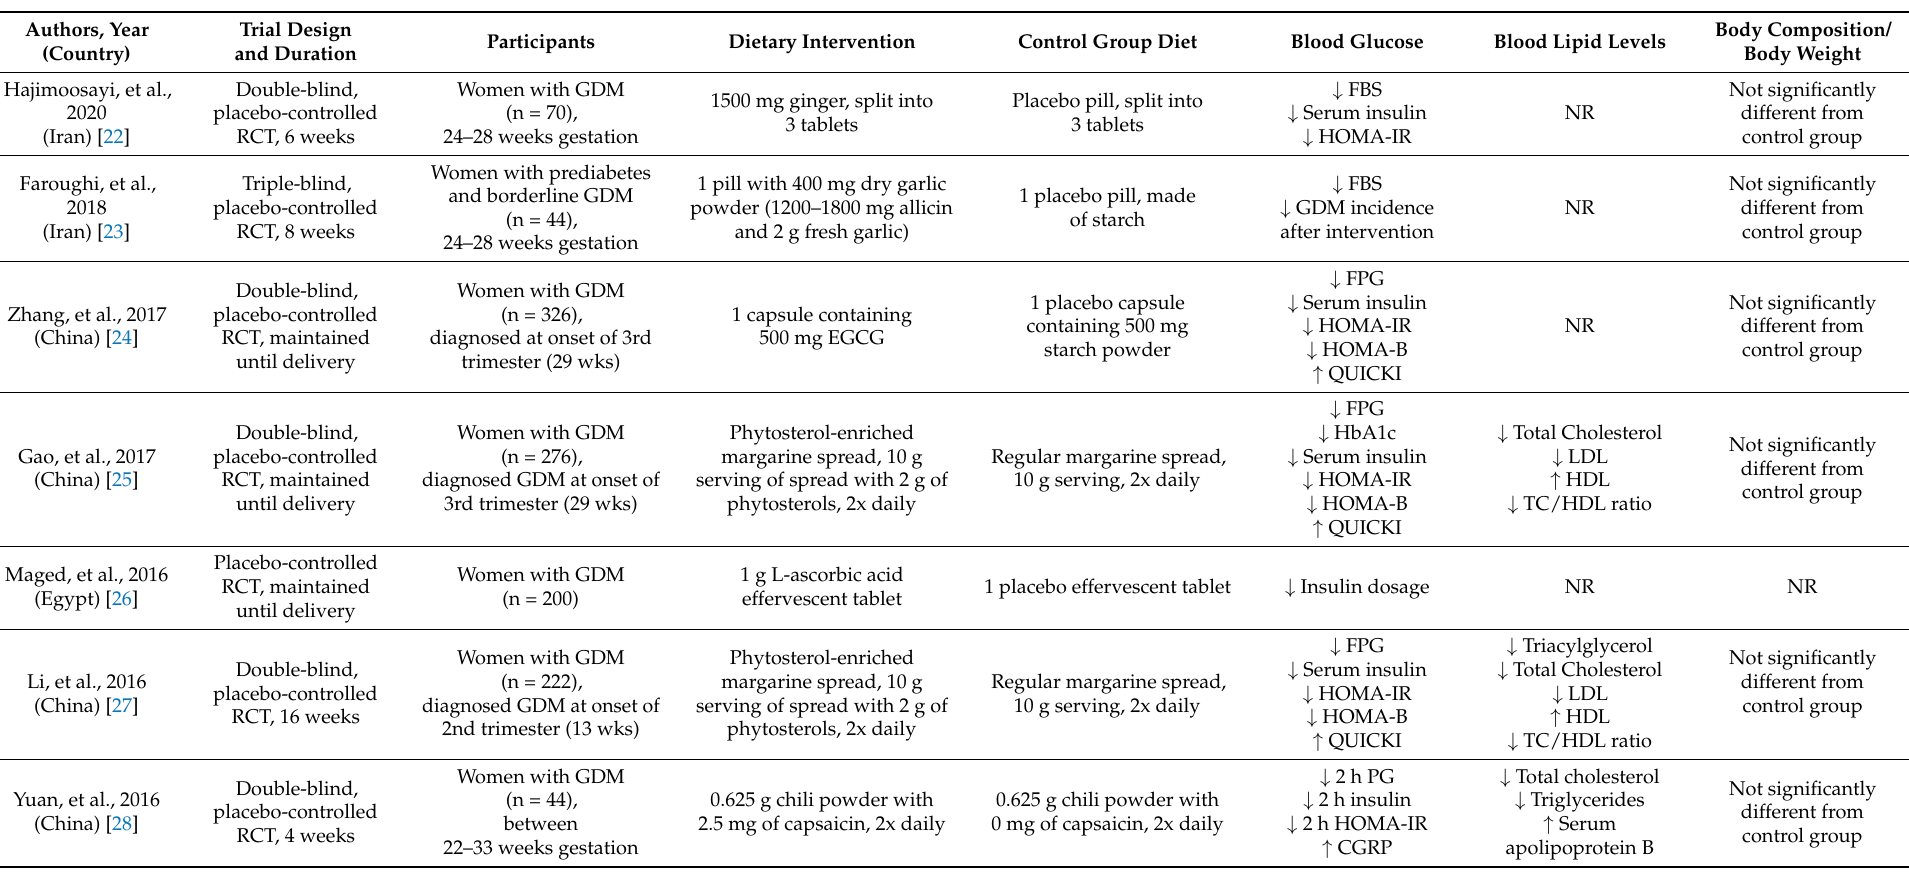
Table 2. Clinical trials on dietary plant-based supplements and their effects on gestational diabetes mellitus risks and